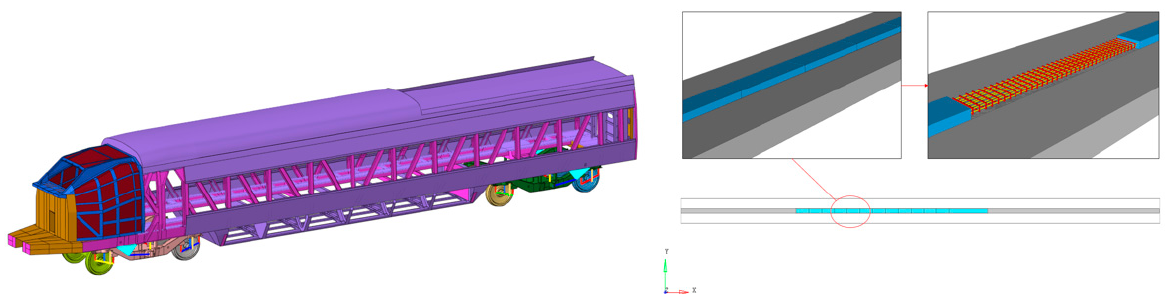
Figure 8. Finite element model for simulation. Table 2. Masses of the high-speed train model. Table 3. The number of finite elements of the simulation